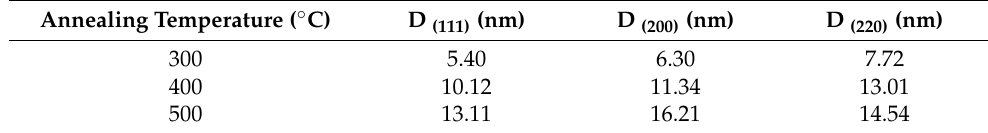
Table 2. Crystallite sizes of NiO films in different directions at different annealing